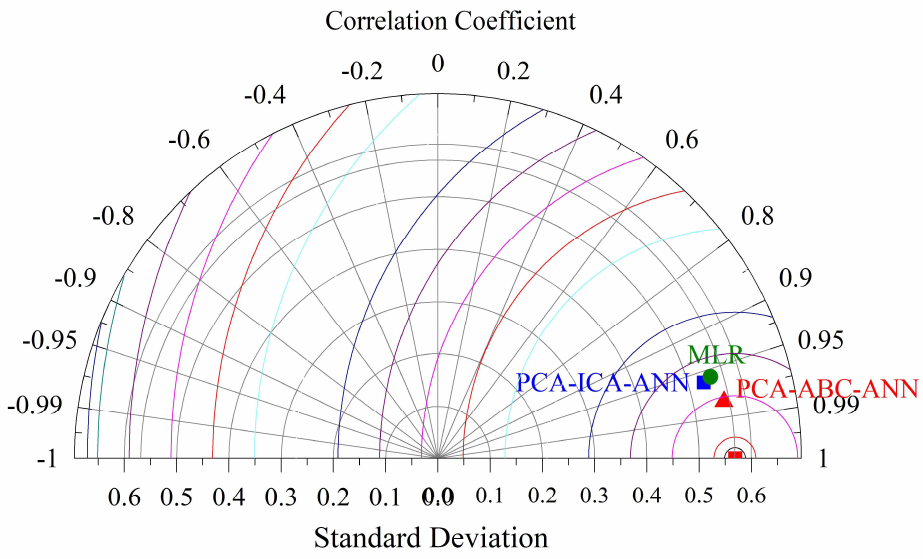
Figure 16. Taylor diagram visualization of the model performance in AR.